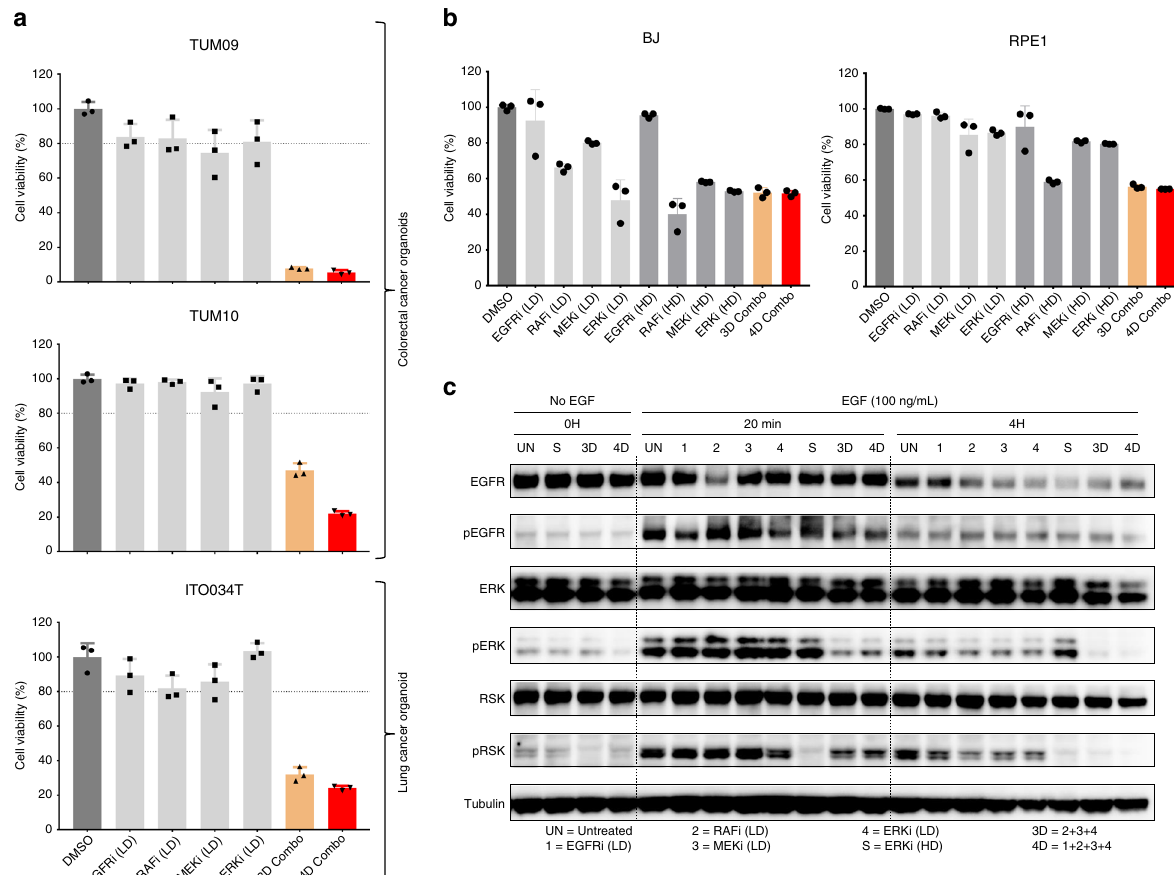
Fig. 3 MLD therapy is effective in patient-derived organoids and is tolerated by normal cell lines. a MLD therapy is effective in several colorectal and lung cancer patient-derived organoids. Organoids were cultured with DMSO, with EGFR, RAF, MEK and ERK inhibitors at LD and with 3D and 4D combos. After 5 days of drug treatment cell viability was measured using CellTiter-Glo ® . Standard deviation (SD) from 3 biologically independent replicates is plotted. b Cell viability of normal cells is much less affected by MLD therapy than tumour cells. BJ and RPE1 cells were treated with DMSO, with EGFR, RAF, MEK and ERK inhibitors at low and high doses and with 3D and 4D Combos (using the LD and HD concentrations determined for PC9 cells). After 4 days of drug treatment cell viability was measured. SD from 3 replicates is plotted. c MLD therapy allows pulsed signaling in normal cells. BJ cells, after overnight starvation, were treated with the indicated inhibitors/concentrations for 2 h, after which EGF (100 ng/mL) was added. Cells were harvested before, 20 min and 4 h after EGF stimulation. The level of pathway inhibition was measured by examining pERK and pRSK protein levels. The level of EGFR inhibition was measured by examining pEGFR protein levels in the western blot. Tubulin was used as loading